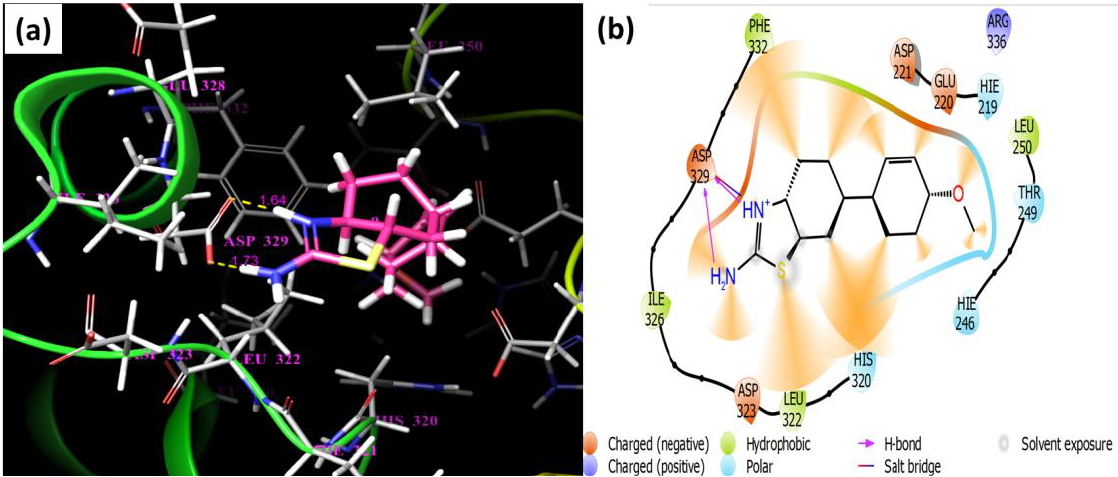
Figure 8. ( a ) Schematic diagram of protein and ligand 3 depicts three-dimensional complex, while ( b ) depicts two-dimensional interactions of the protein and ligand. Hydrogen bonds, as well as other interactions, are displayed in the two-dimensional figure. Table 7. Binding energies (kcal/mol) of urease (PDB: 2KAU) with selected ligands 1 to 5 . Compounds